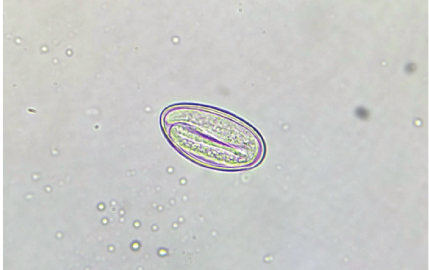
Figure 8: Non-bile-stained ovum of Enterobius vermicularis with larva inside on normal saline wet mount, under high